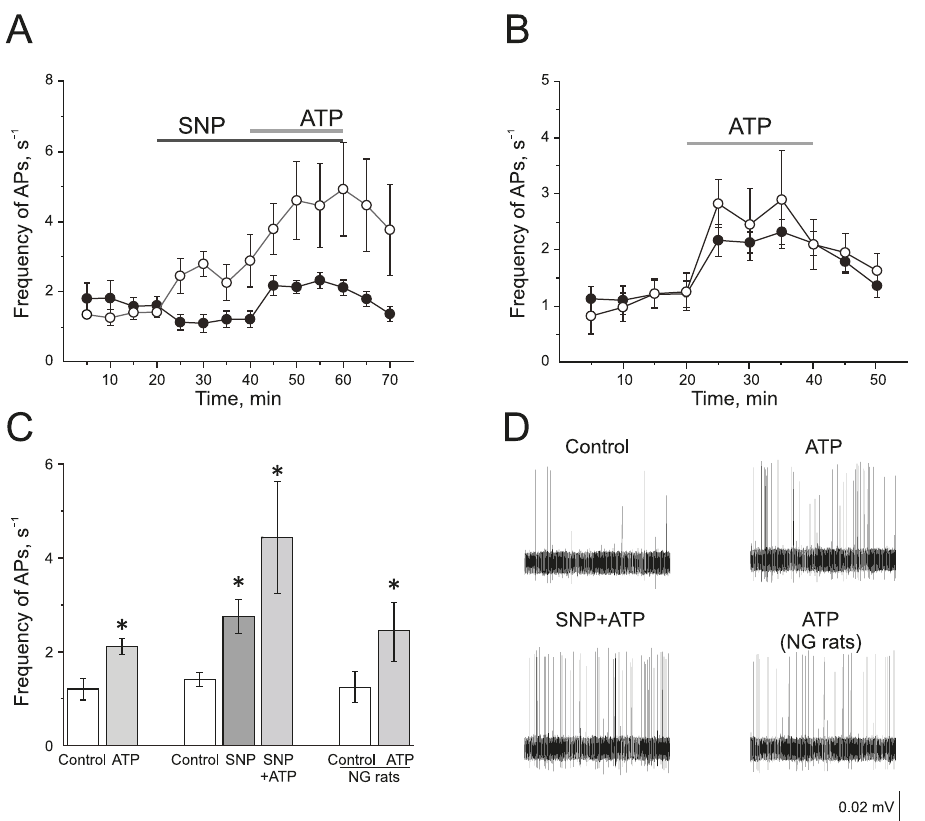
Figure 3. The role of NO in the pro-nociceptive action of ATP in the trigeminal nerve afferents. ( A ) The time-course of AP frequency during ATP (100 µ M) application in the control group (black circles) and in the group after the application of the NO donor (SNP 200 µ M, white circles); ( B ) The time-course of the AP frequency during the application of ATP in the control (black cir- cles) and in the nitroglycerine (NG)-induced migraine model (white circles); ( C ) Histogram showing the maximum frequency of AP per 5 min in the control, after the application of ATP; SNP, ATP in the presence of SNP and the effect of ATP in the NG-induced migraine model group (NG rats); ( D ) Sample traces of AP in the trigeminal nerve in the control, after the application of ATP, application of ATP in the presence of SNP, and application of ATP in the NG-induced migraine model group (NG rats). Mean ± SEM. * p <